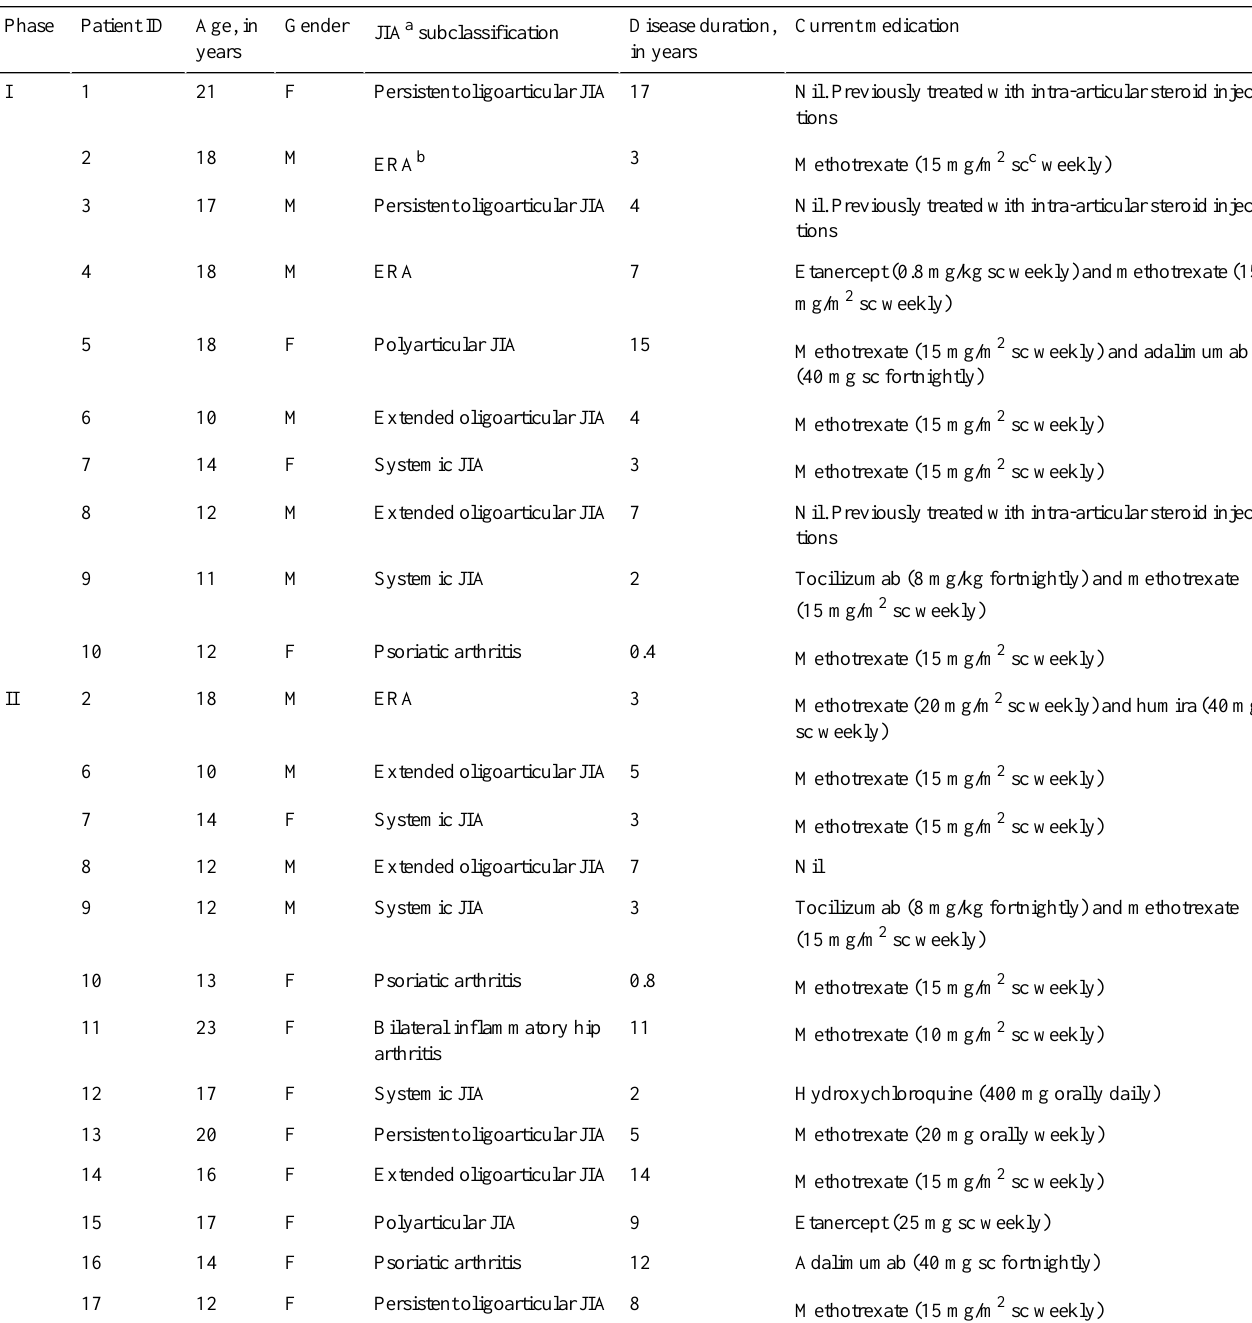
Table 1. Patient baseline characteristics, disease duration, and treatment